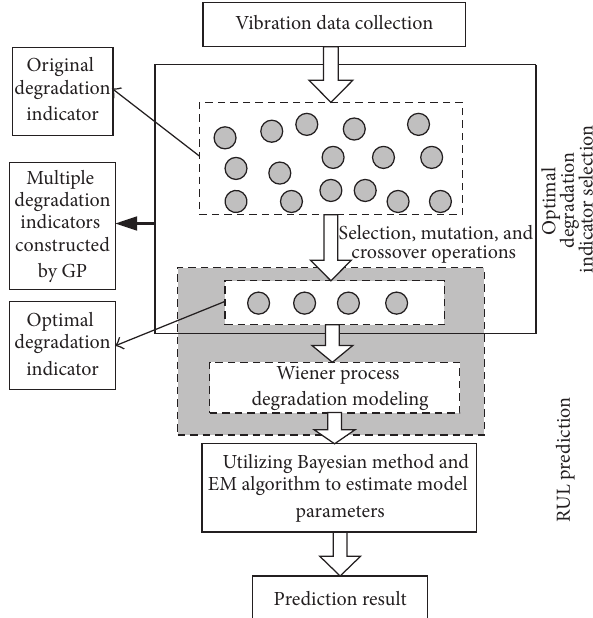
Figure 2: Remaining useful life prediction